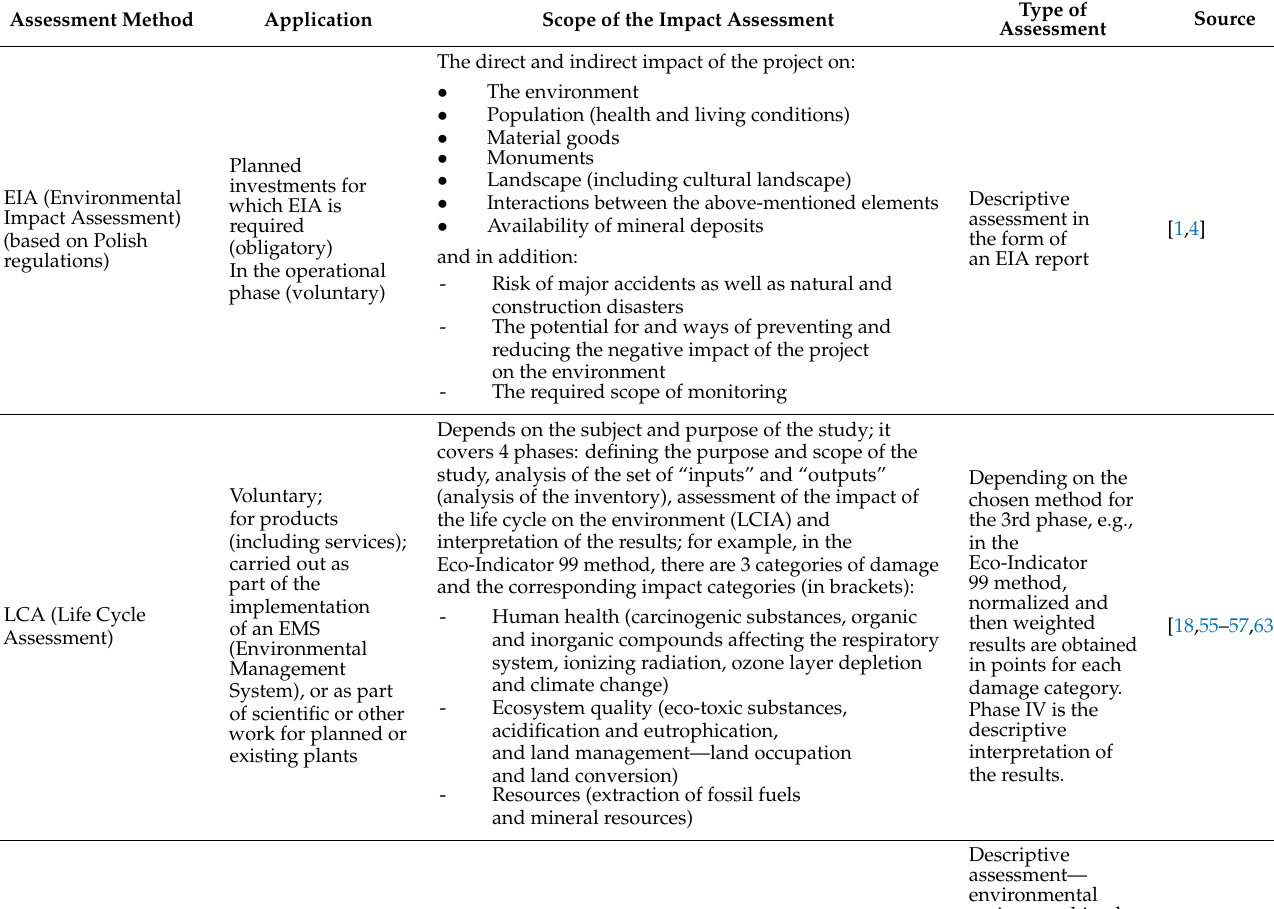
Table 1. Comparison of methods of assessing the impact of wastewater treatment plants on the environment. Assessment